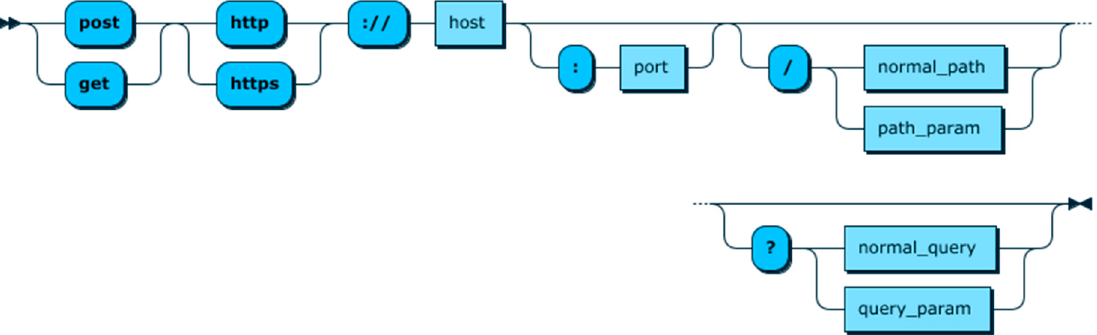
Figure 18. API-based aggregation functions.